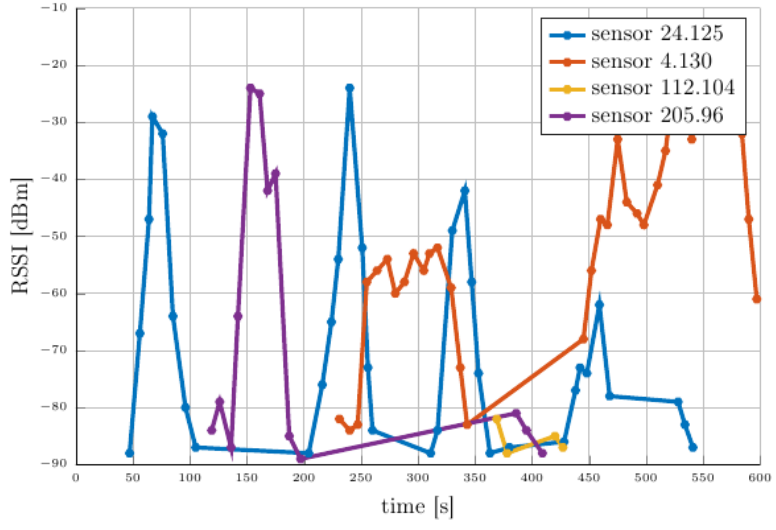
Figure 16. RSSI for each unicast along the experimental run.